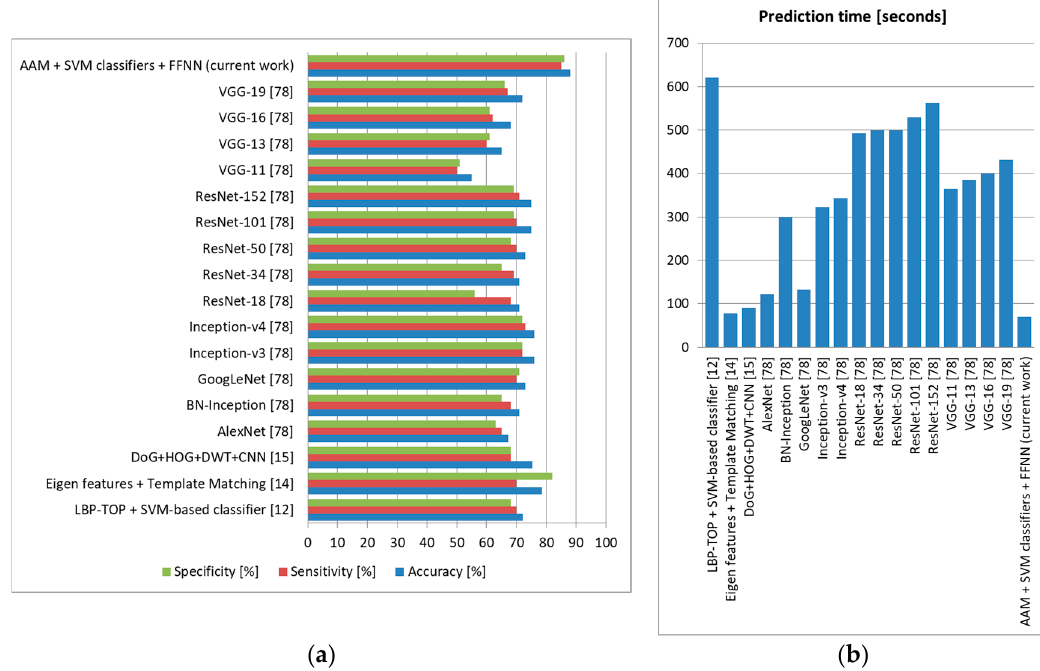
Figure 17. Stress prediction comparison to state-of-the-art methods (ANUStressDB [12]). ( a ) Average accuracy, sensitivity, and specificity, ( b ) Average prediction time (seconds).